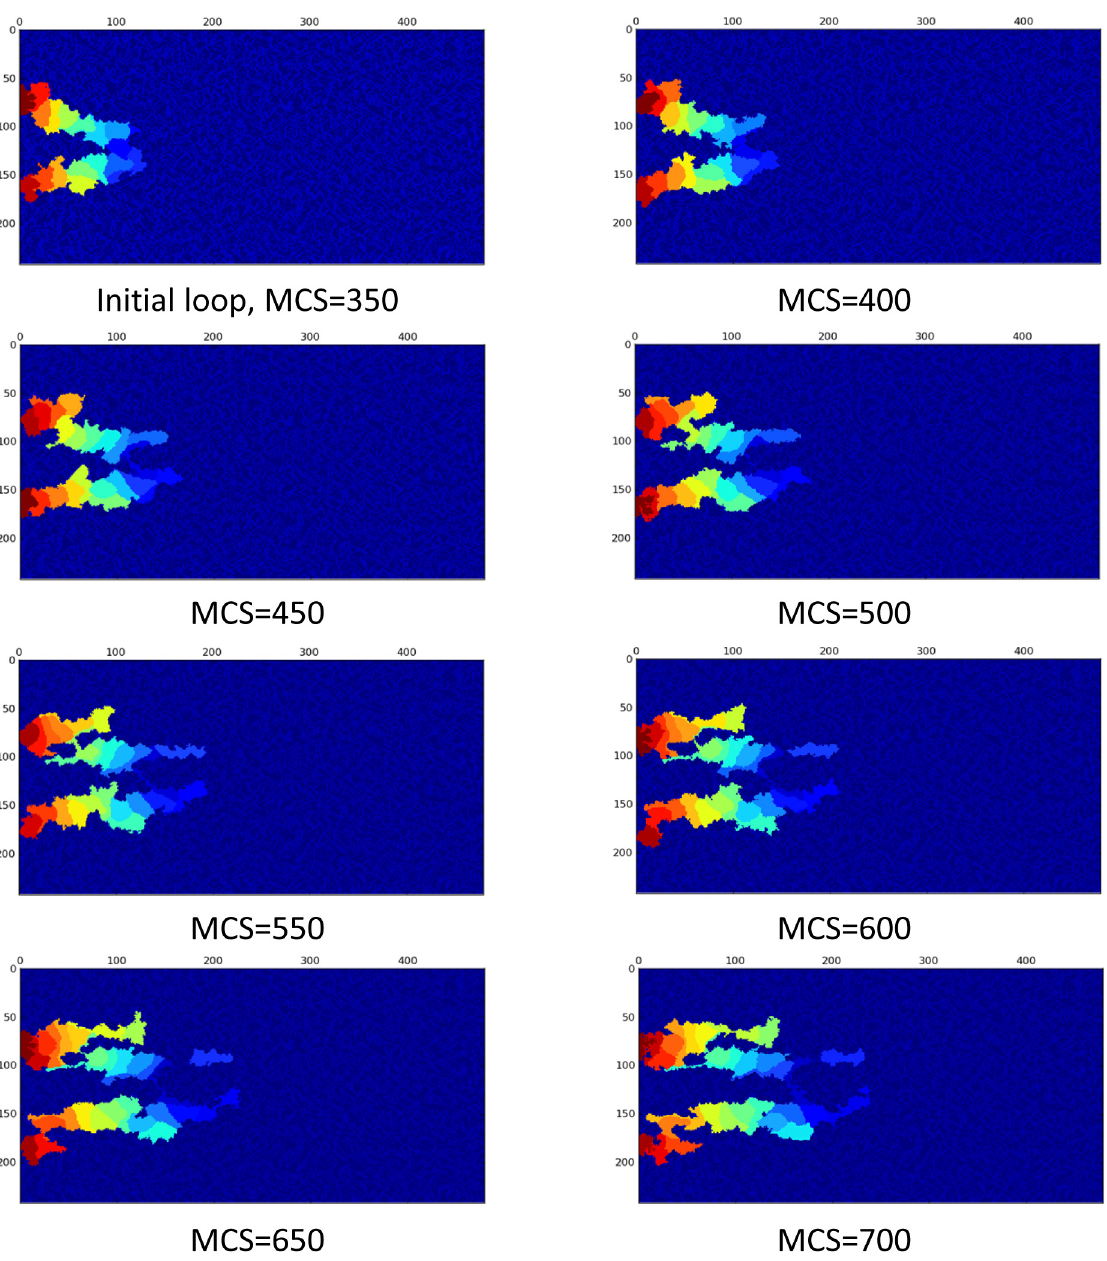
Fig 10. Loop collapses when effect of flow in the cell phenotype is neglected. The complete collapse is obvious after 700 MCS. The X and Y-axis show the domain size in μ